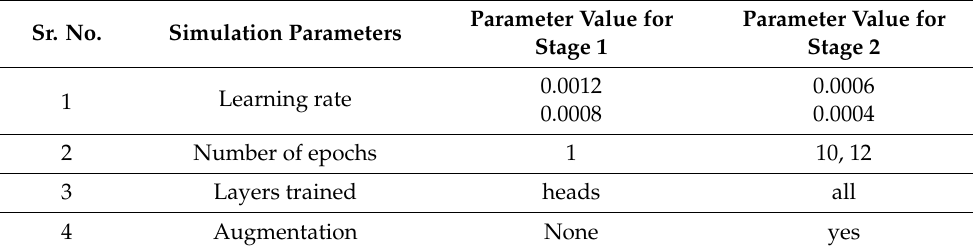
Table 6. Simulation parameters for stage 1 and stage 2 training.